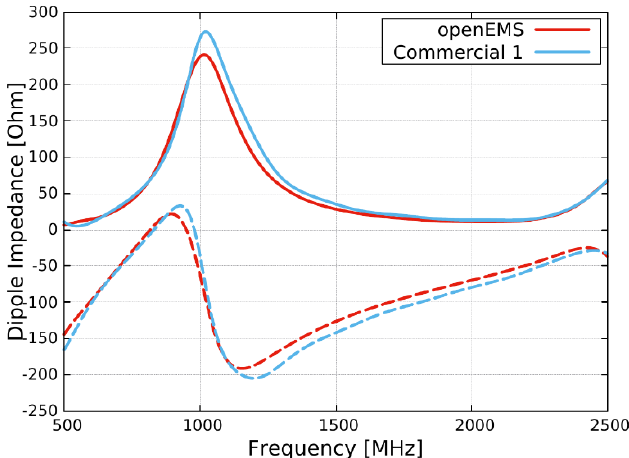
Fig. 1. Comparison of the impedances of a simple printed dipole. Red line: OpenEMS; Blue line: commercial code 1. Continuous lines: real part; Dashed lines: imaginary part.